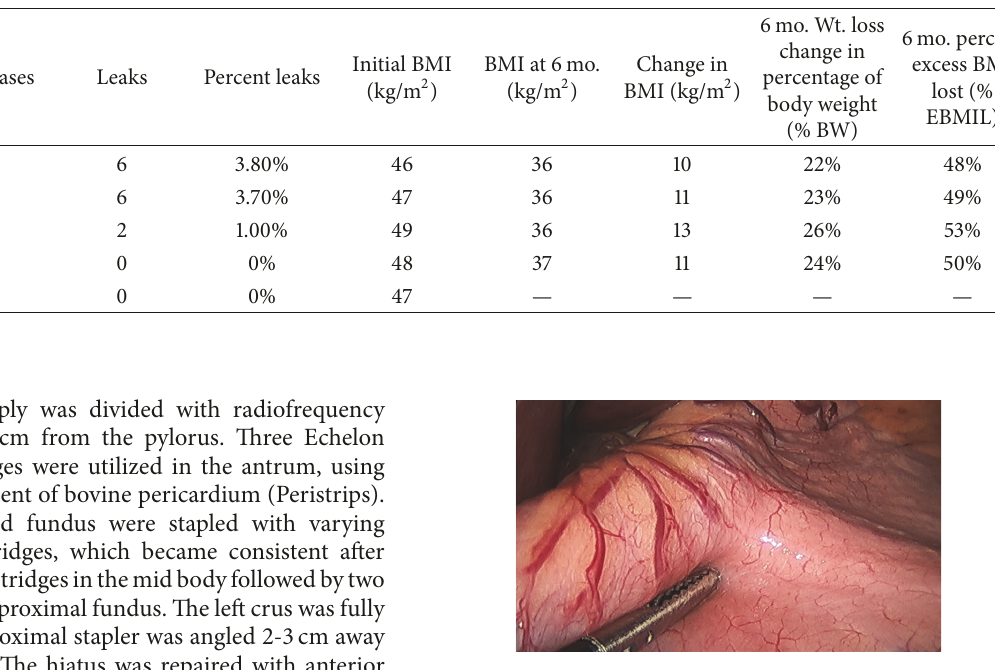
Figure 1: Stomach with 40-French sizing tube within the stomach, positioned along lesser curvature of stomach, in preparation for